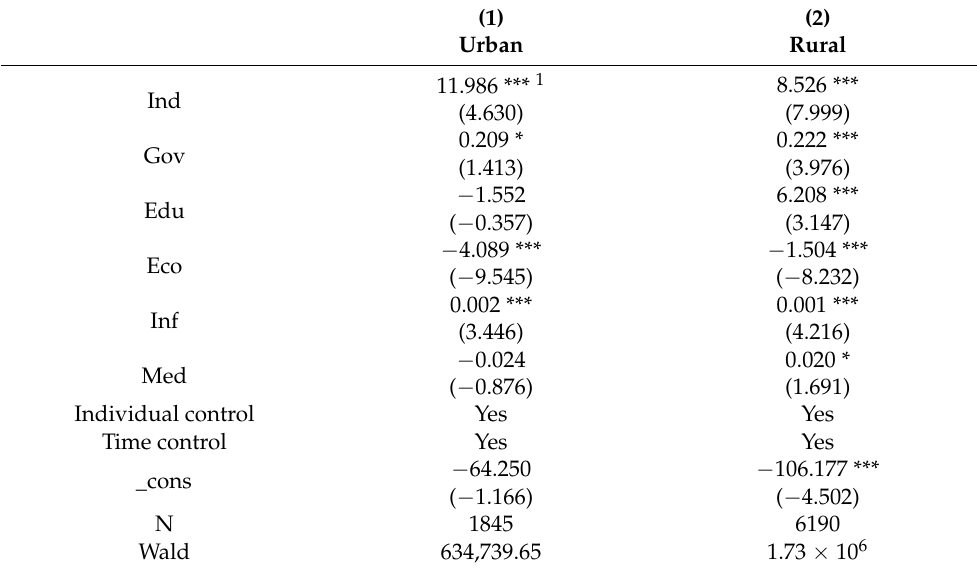
Table 5. Results of the endogeneity